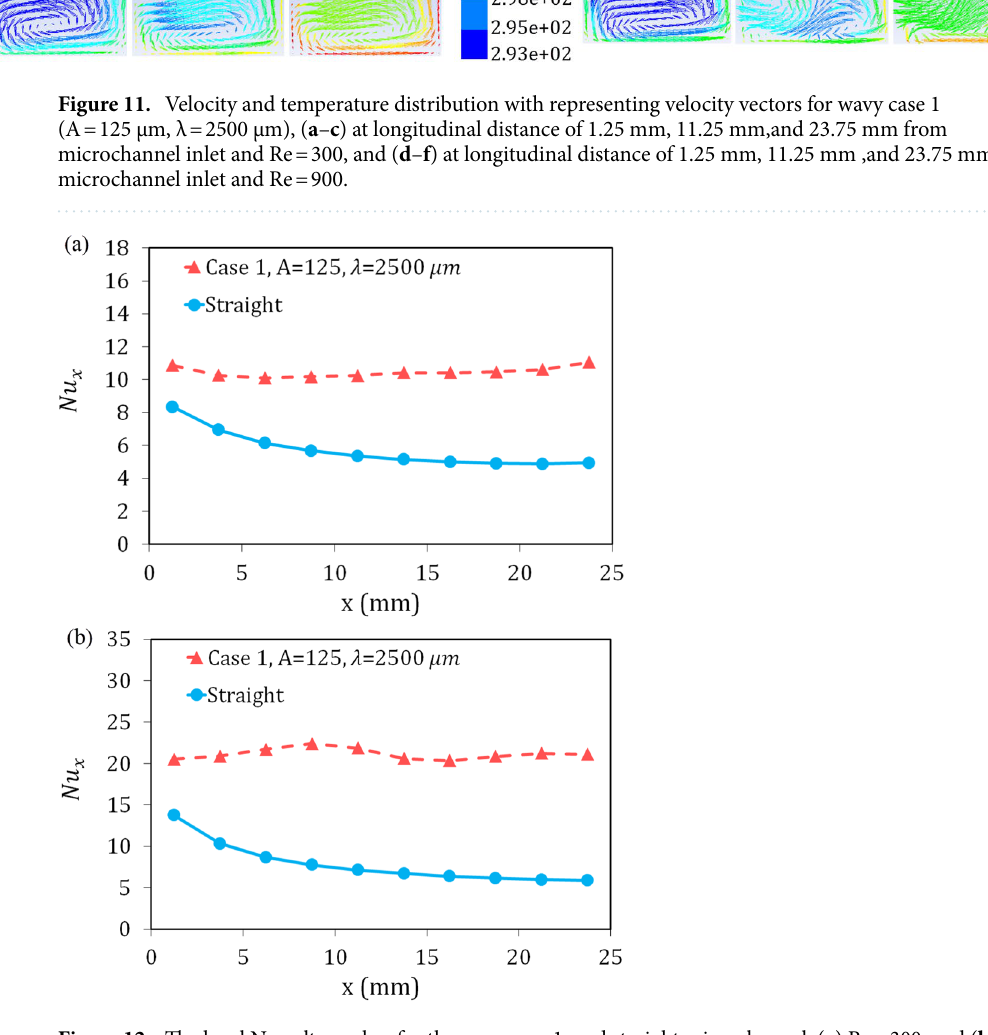
Figure 12. The local Nusselt number for the wavy case 1, and straight microchannel, ( a ) Re = 300, and ( b ) Re =